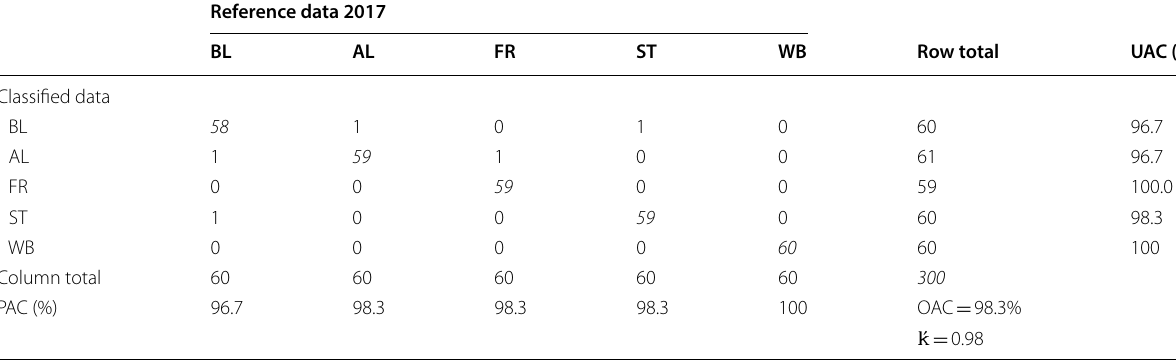
Diagonal elements in italics indicates LULC classes are classified correctly. 300 sample reference points were collected from Google earth images of 2017 and this has also supported by field visit